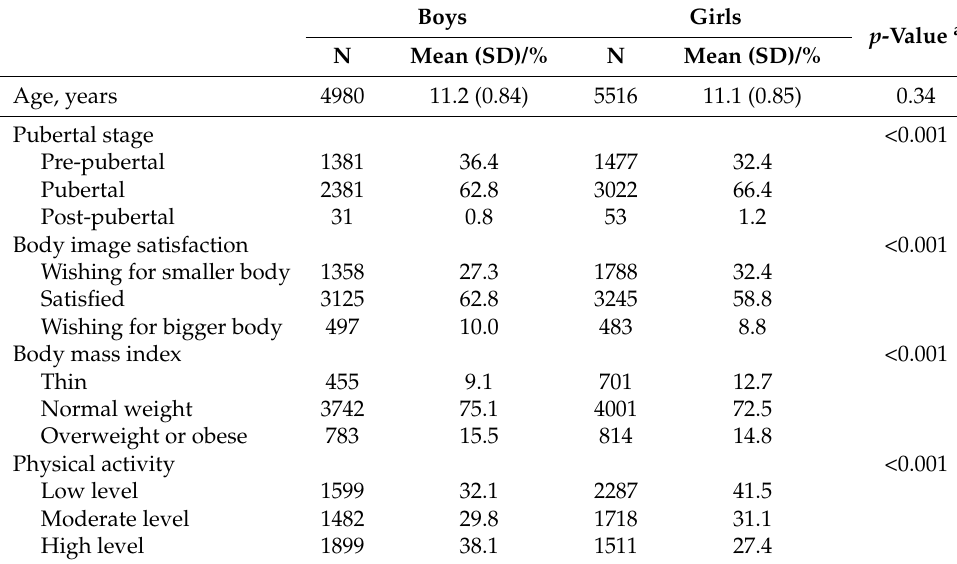
Table 1. Characteristics of participating adolescents (N = 10,496).